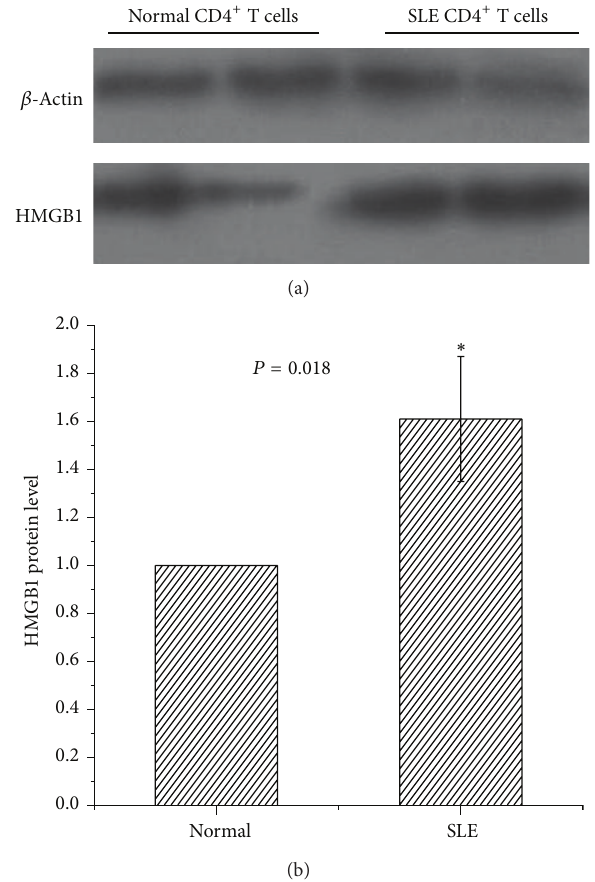
Figure 3: Protein expression of HMGB1 in CD4 + T cells using western blot. (a) Representative western blot showing protein expression of HMGB1 in CD4 + T cells isolated from patients with SLE and healthy controls. (b) Bar chart showing the mean intensity of the bands as determined by densitometric scan, normalized to the house-keeping gene, 𝛽